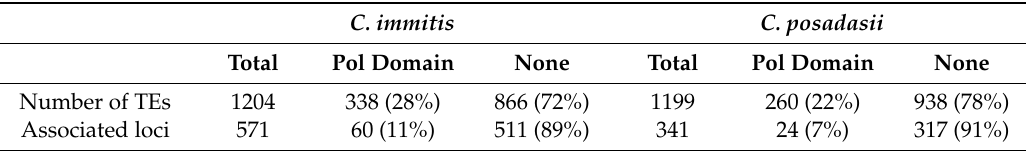
Table 2. Polyprotein domains in Gypsy